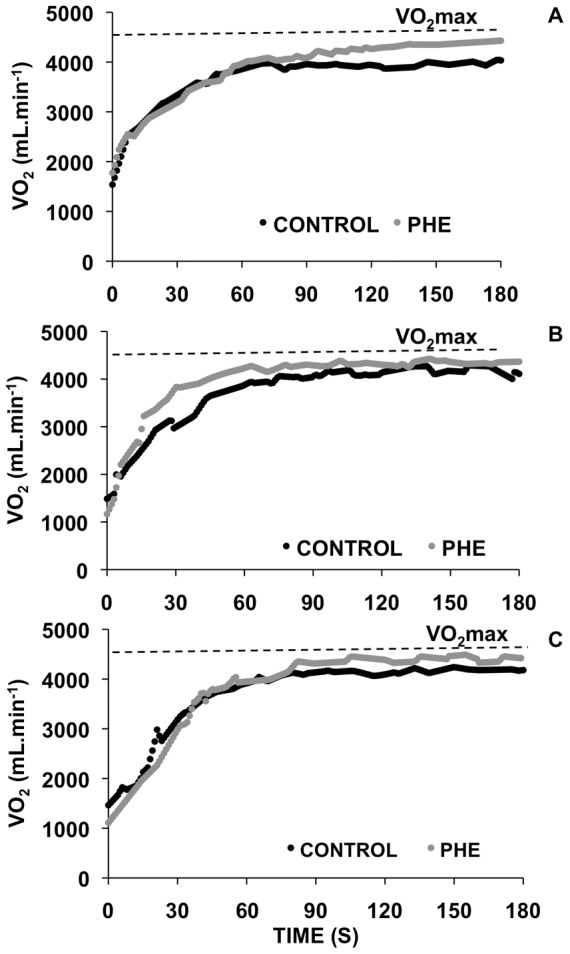
Oxygen uptake (VO2) responses during the pacing exercise conditions in a representative subject.The horizontal line superimposed on each panel indicates the subject's VO2max. Panels A, B and C - slow start, even start and fast start pacing conditions, respectively. Grey circles and black circles - paced exercise trials, with and without prior exercise, respectively. Notice that the VO2 response is speeded using the fast start pacing strategy only in the control condition. Thus, the fast start pacing strategy does not magnify the positive effects of prior heavy-intensity exercise on overall VO2 response.